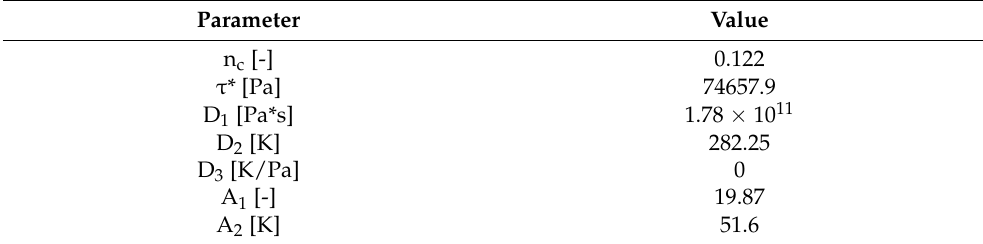
Table 2. The Tait parameters of the K30 biocomposite model.